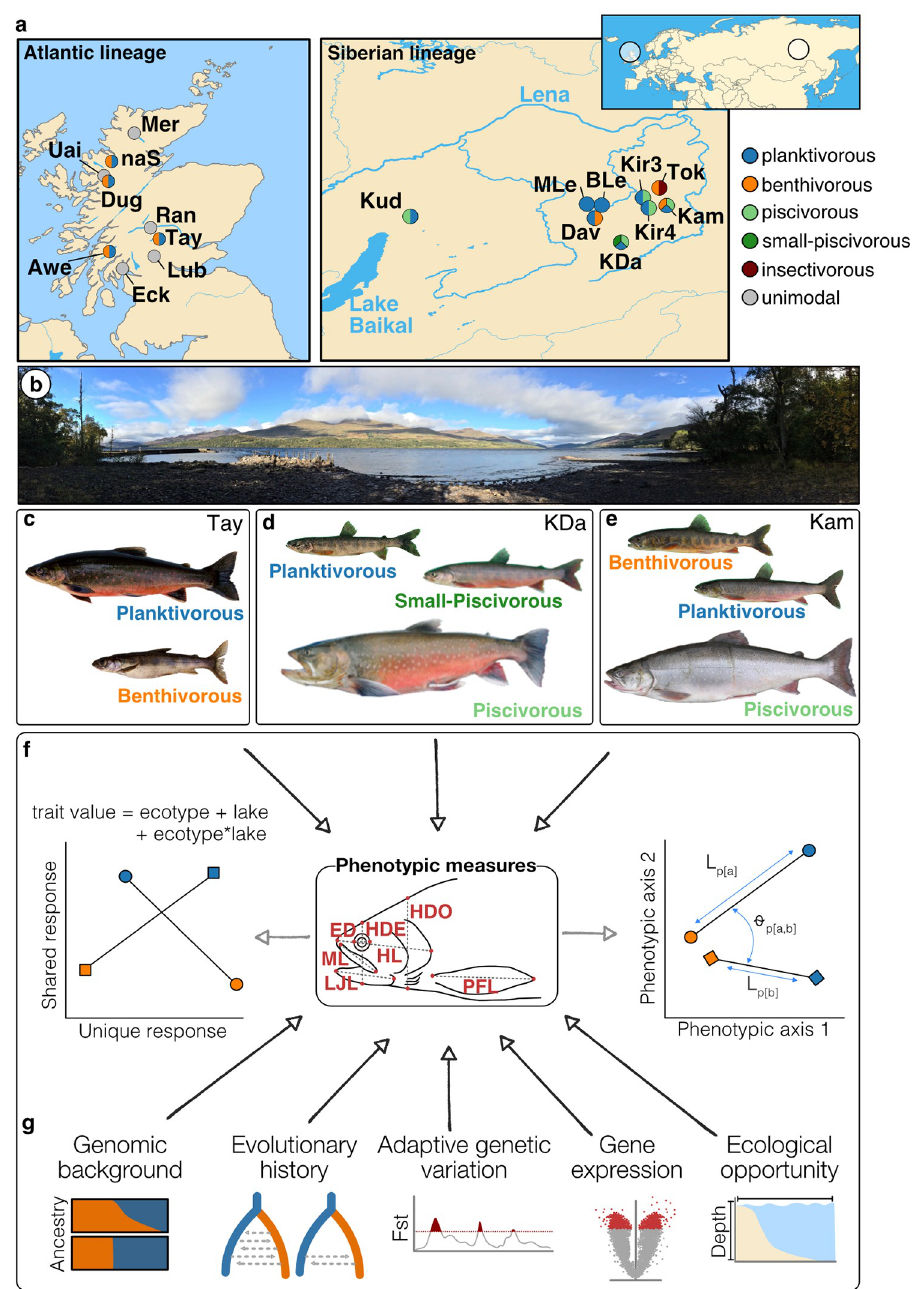
Fig 1. Sampling locations, ecotypes and study design. ( A ) Maps showing the sampling locations of Arctic charr from the Atlantic lineage in Scotland (N = 440) and the Siberian lineage in Transbaikalia, Russia (N = 1,009). The colour combination of each dot shows the ecotypes sampled from each location. Full names of lakes are given in S1 Table. ( B ) Picture showing the sampling site at Loch Tay in Scotland. ( C – E ) Representative individuals of the ( C ) two sympatric ecotypes from Loch Tay in Scotland and the three sympatric ecotypes from ( D ) Kalarskii Davatchan (KDa) and ( E ) Kamkanda (Kam) in Transbaikalia. Individuals not to scale. ( F-G ) The study design is centred around testing the ( F ) extent of phenotypic parallelism between replicated ecotypes within and across two evolutionary lineages using phenotypic trajectory analyses (illustrated on the right) and variance partitioning with linear models (illustrated on the left) based on 7 linear measurements (shown in the middle). Linear traits measured: HDE–head depth at eye, HDO– head depth at operculum, HL–head length, PFL–pectoral fin length, ED–eye diameter, ML–maxilla length, LJL–lower jaw length. Fork length (FL) was also measured. ( G ) In addition, we analysed the extent of parallelism from the genomic background to gene expression and assessed the impact of variation on these different organisational levels on the extent of phenotypic